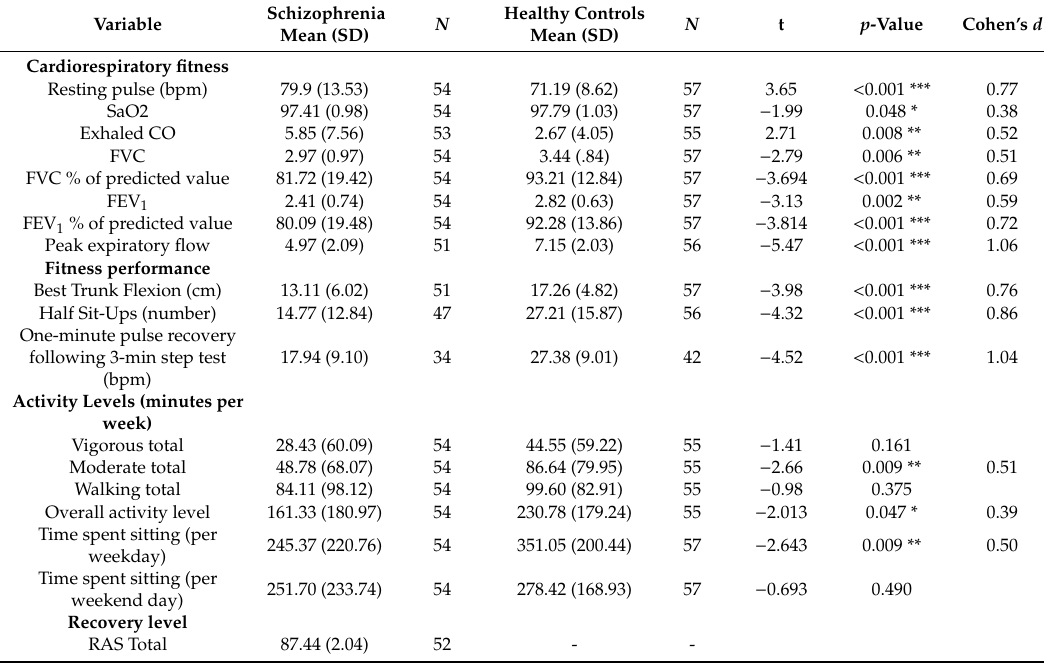
Table 2. Physical fitness, activity levels, and degrees of recovery among participants with schizophrenia vs. healthy